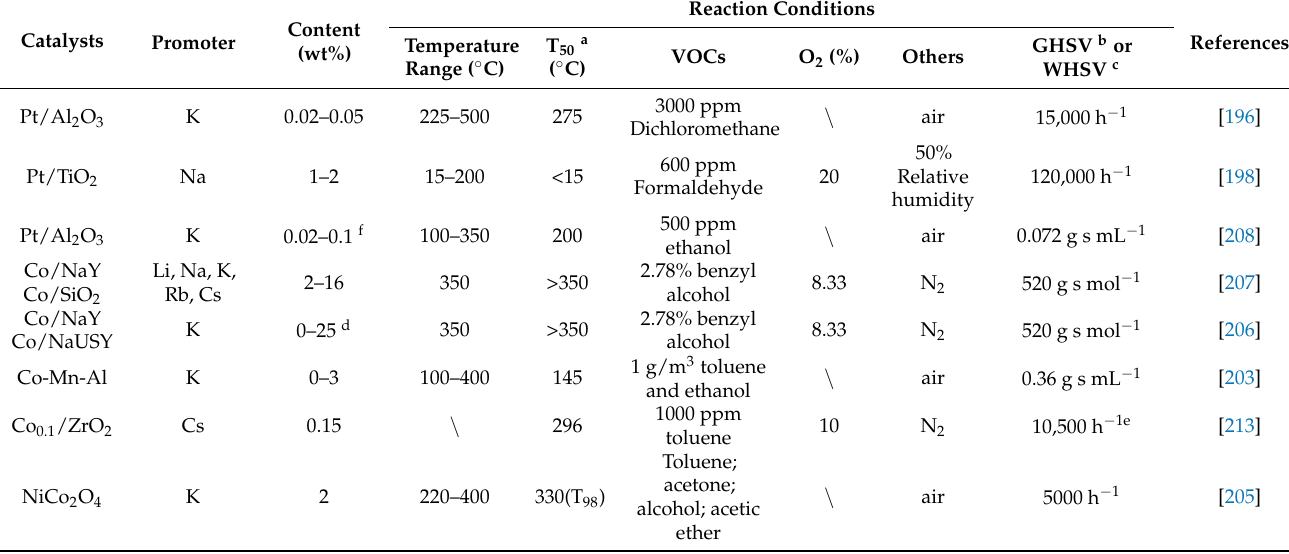
Table 10. Summary of catalysts and reaction conditions for volatile organic compounds (VOCs) oxidation catalysts promoted by alkali